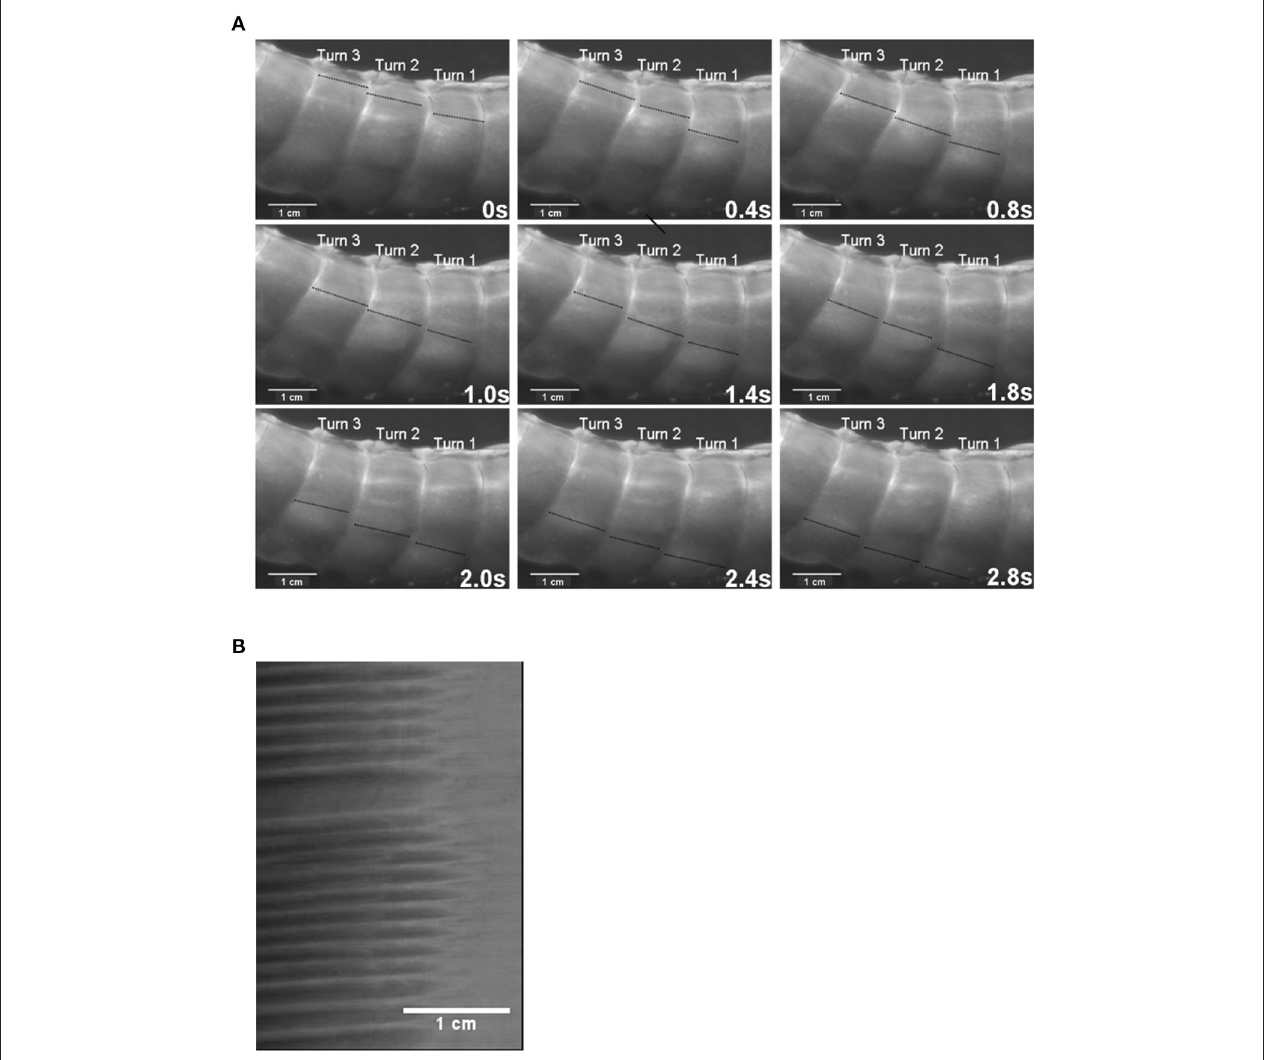
FIGURE 8 | The use of I maps in determining the frequency of ladder contractions in the rabbit caecum. Photo sequence (A) shows a sequence of video frames of lengthwise ladder contractions (dark lines) in three successive spiral turns of the mid caecum at 0.4s intervals. The I type ST map (B) is taken from of a single spiral turn during the transit of ladder contractions. The X axis represents the width of the turn (number 2 on the photo sequence) with the proximal end of the preparation to the right. Note that the arrays of contractions do not occupy the proximal third of the turn and that the slope of the largely regular sequence of contractions indicates that they are propagating from the proximal to the distal end of the turn. Figure adapted from Hulls et al. (2012).